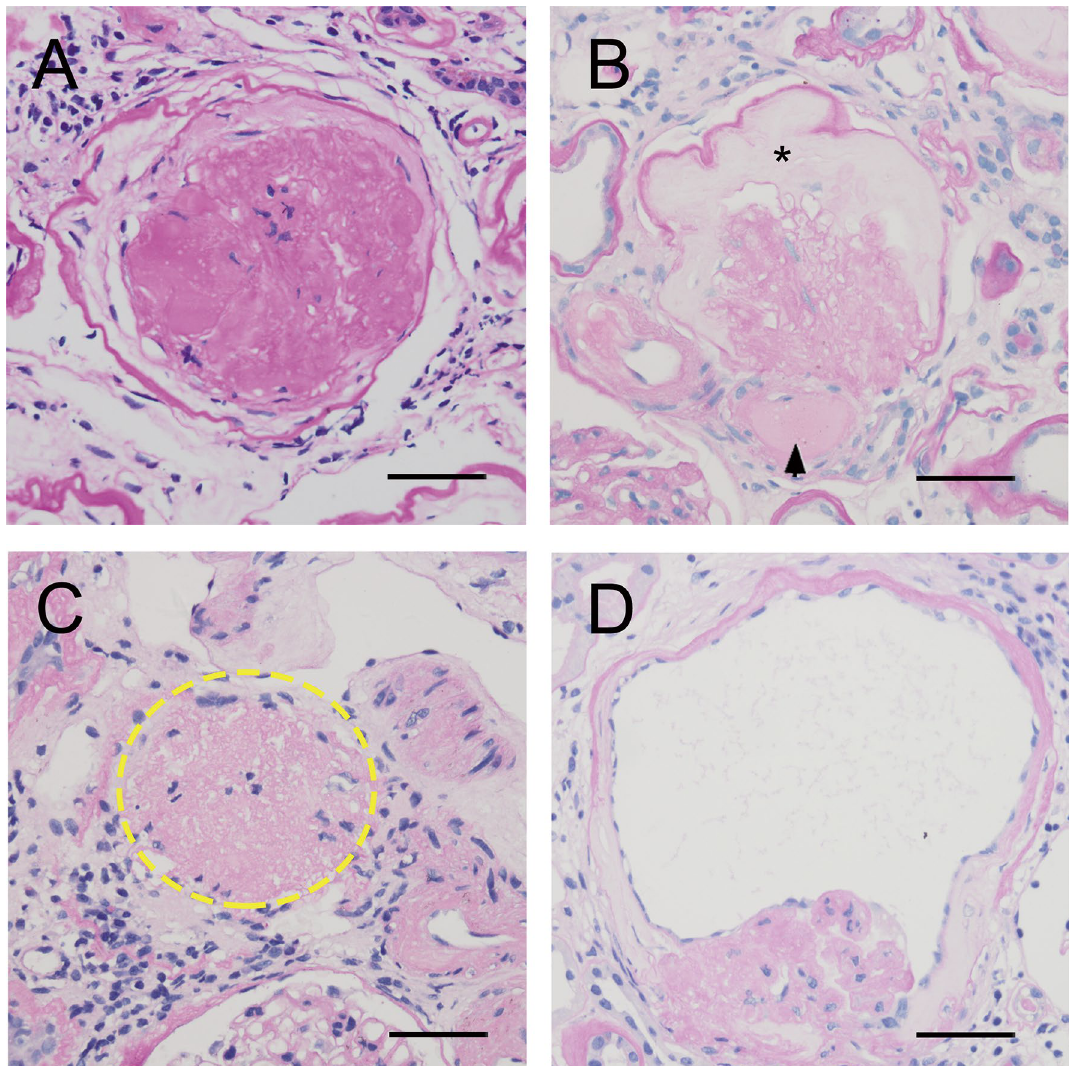
Figure 4. Light photomicrographs of the different patterns of global glomerulosclerosis in diabetic nephropathy. ( A ) Solidified glomerulosclerosis is characterised by expansion of the mesangial matrix of the glomerular tuft, which fills Bowman’s capsule (periodic acid-Schiff [PAS], × 400). ( B ) Obsolescent glomerulosclerosis is characterised by wrinkling of the glomerular basement membrane, with subsequent glomerular tuft retraction toward the vascular pole, and gradual accumulation of collagenous connective tissue (stars), beginning at the vascular pole adjacent to the glomerular stalk. Severe arteriolar hyalinosis (arrowhead) can also be observed (PAS, × 400). ( C ) An example of not otherwise specified glomerulosclerosis, showing disappearing glomerulosclerosis (dashed line), and absence or partial disappearance of Bowman’s capsule, such that there is a continuum between the sclerotic glomerulus and the fibrotic interstitium (PAS, × 400). ( D ) Another example of not otherwise specified glomerulosclerosis, showing a shrunken glomerulus surrounded by inflamed interstitium (PAS, × 400). Bar = 50